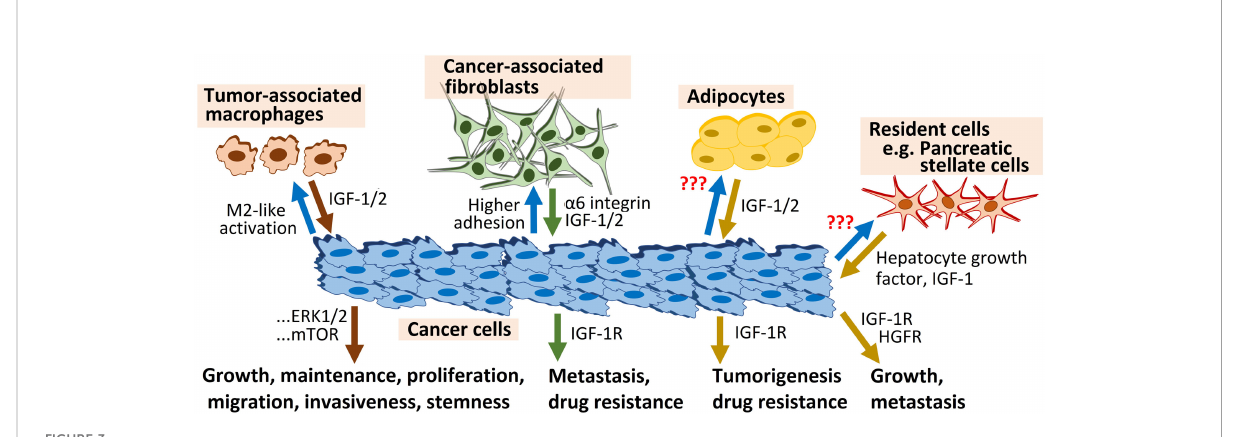
FIGURE 3 IGF-1R signaling triggered by the microenvironment fuels